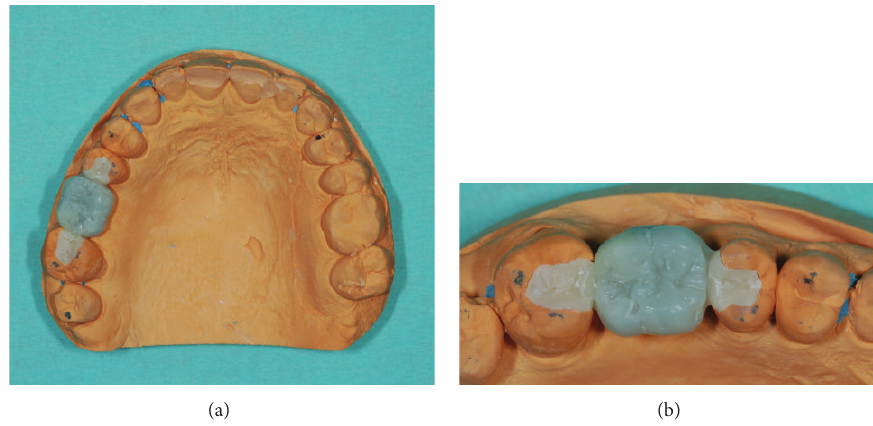
Figure 4: (a) Type IV gypsum master cast with the composite resin try-in of the IRFDP. (b) Close-up of the mock-up; the occlusal contacts were verified by the technician using the articulator.